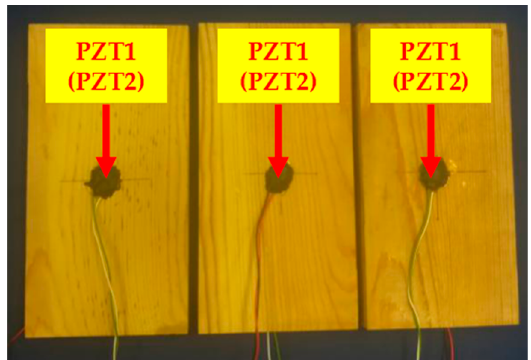
Figure 2. Timber specimens. (PZT2 is at the same position, on the back side). From left to right: Specimen 1, Specimen 2, Specimen 3.